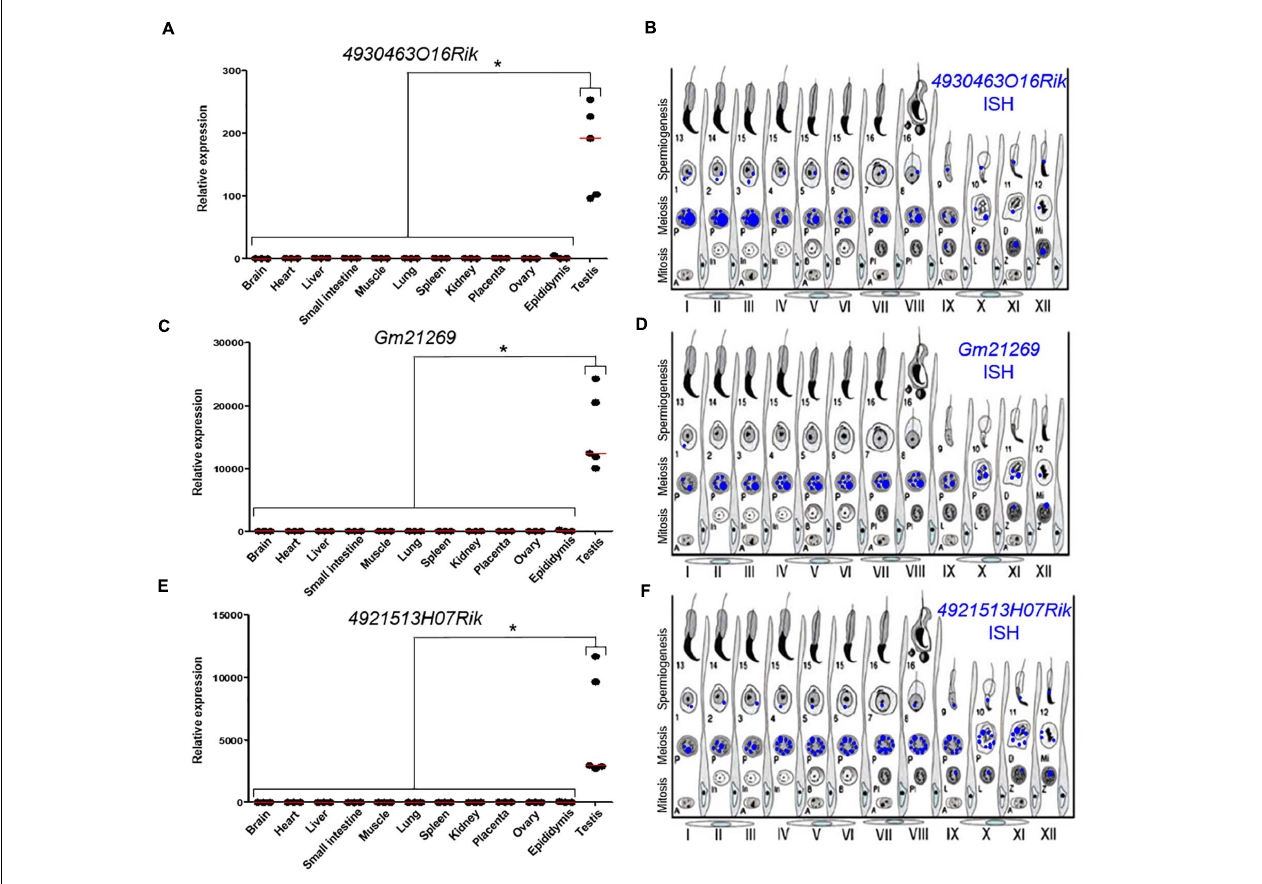
FIGURE 2 | Expression analysis of three lncRNAs. (A,C,E) RT-qPCR analysis of three different lncRNAs. (A) 4930463O16Rik ; (C) Gm21269 ; (E) 4921513H07Rik in different 2-month-old tissues from WT mice. The red lines represent the median for each tissue; n = 5 for testes and n = 3 for other organs. Statistical analyses were performed using the non-parametric Kruskal–Wallis test. * p < 0.05 (B,D,F) Schematic representation of the results of (B) 4930463O16Rik , (D) Gm21269, and (F) 49215113H07Rik IS H expression in meiotic and post-meiotic cells of the WT mouse seminiferous epithelial